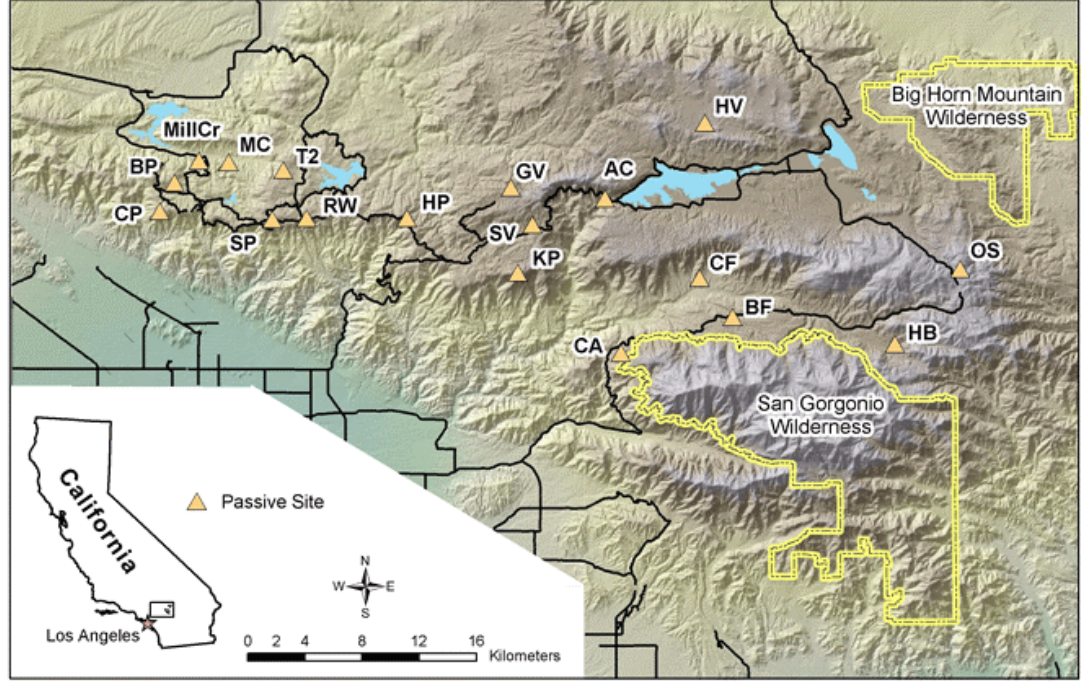
FIGURE 2 . Locations of air pollution/forest health monitoring sites in the SBM from West to East: CP, Camp Paivika; BP, Breezy Point; MillCr, Mill Creek; SP, Strawberry Peak; MC, Miller Canyon; T2, Tunnel 2; RW, Rim of the World; HP, Heaps Peak; SV, Snow Valley; GV, Green Valley; KP, Keller’s Peak; CA, Camp Angeles; AC, Arctic Circle; HV, Holcomb Valley; CF, Converse Flats; BF, Barton Flats; HB, Heart Bar; OS, Onyx